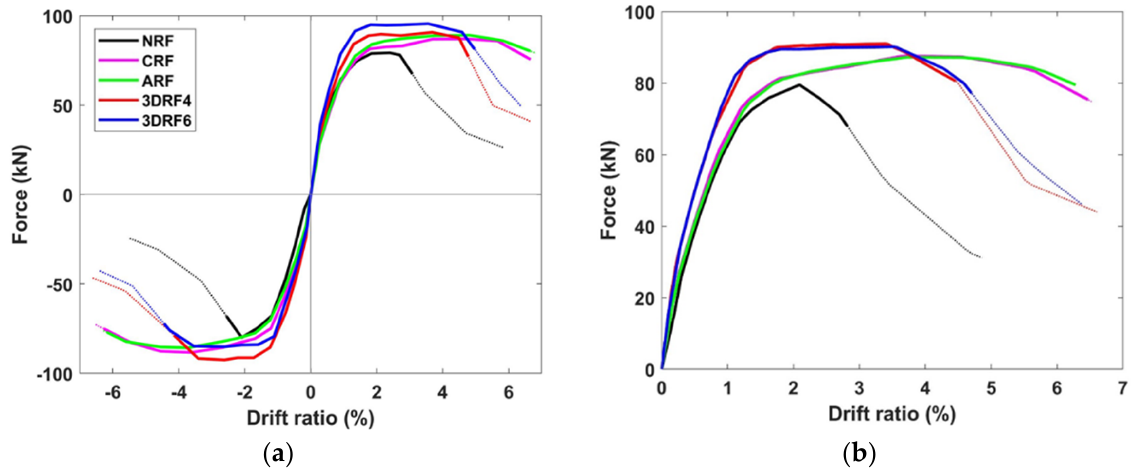
Figure 11. Envelope curve: ( a ) Both directions; ( b ) Average curve.